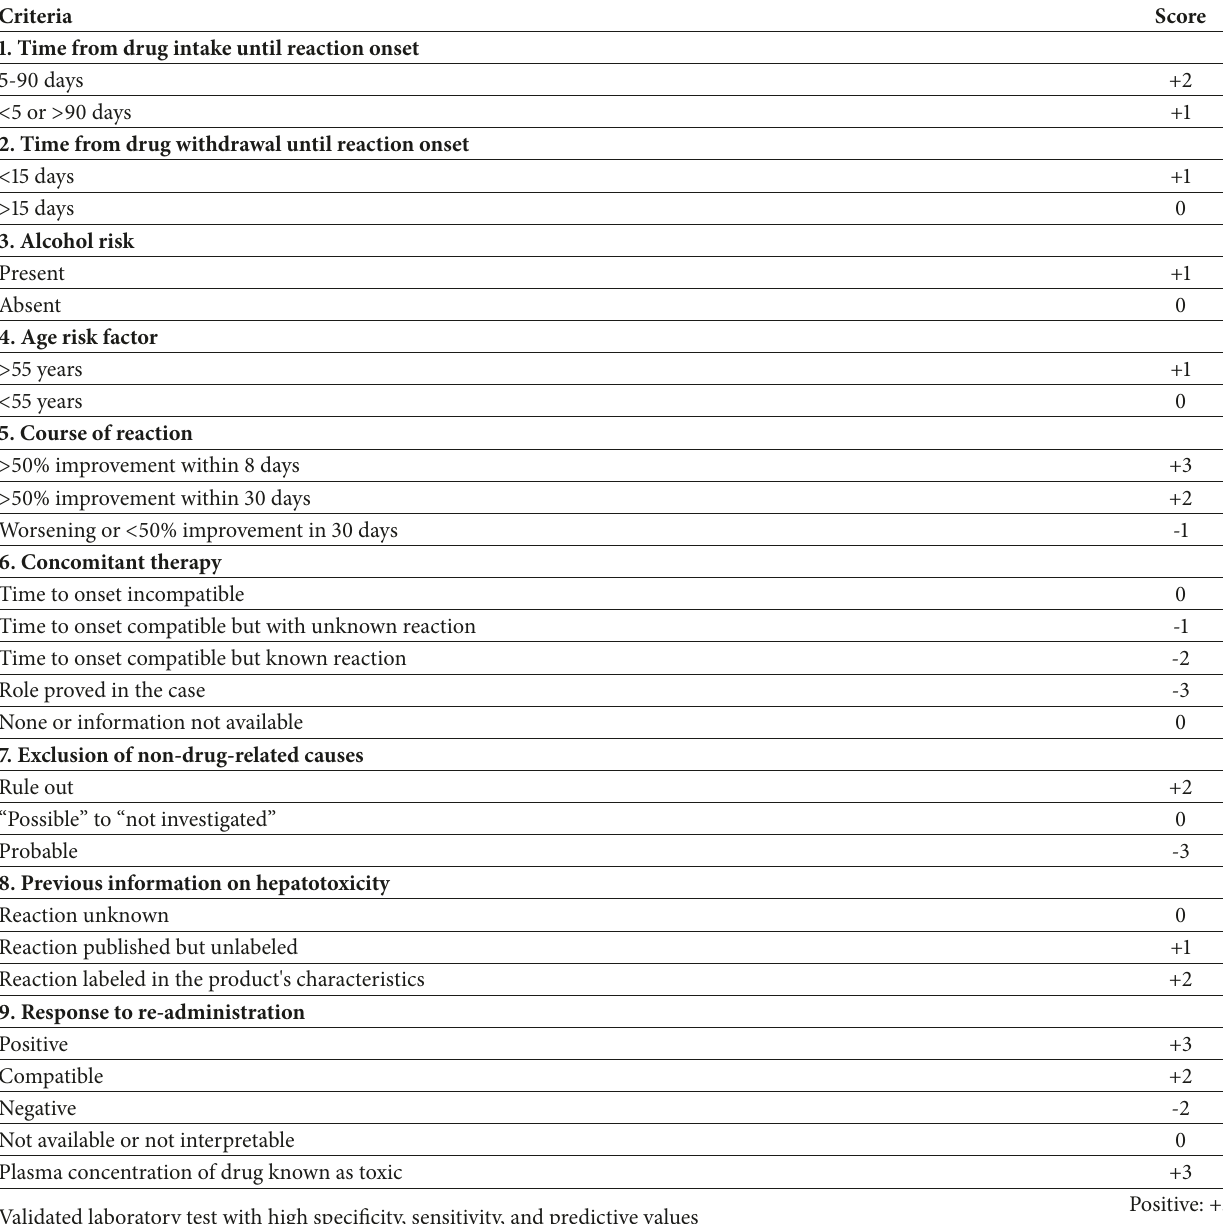
Table 1: CIOMS/RUCAM